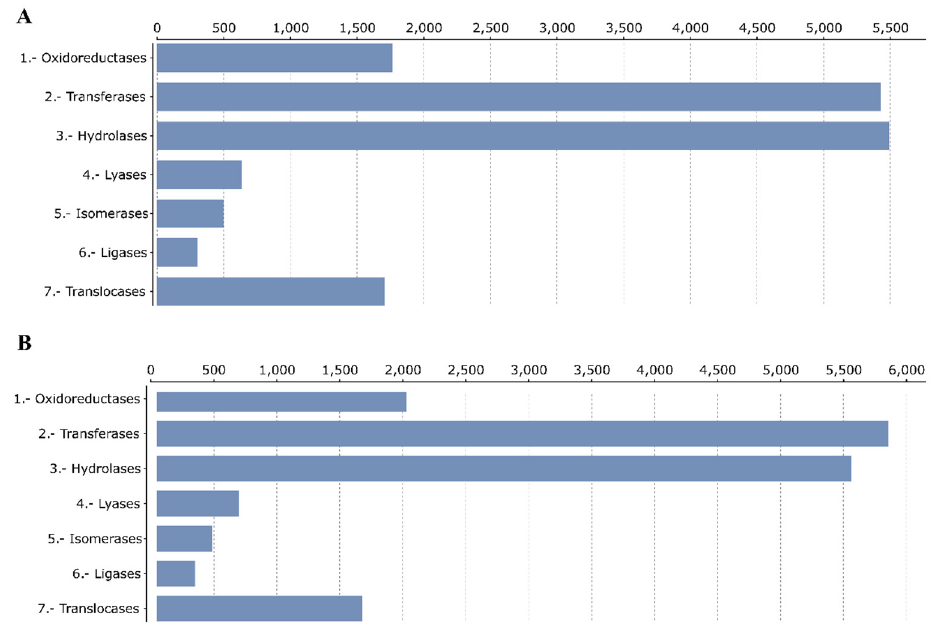
Figure 7. Number of unigenes for each enzyme commission (EC) category for tree tomato A21 ( A ) and A23 ( B ) transcriptomes.